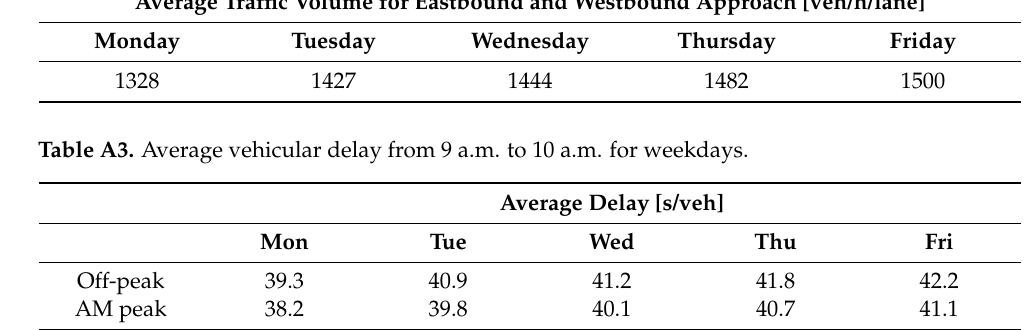
Table A2. Traffic volumes for weekday 9 a.m. to 10 a.m.